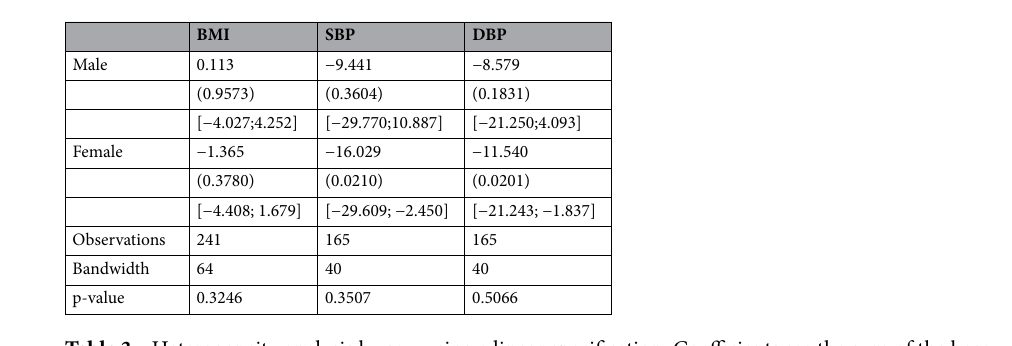
Table 3. Heterogeneity analysis by sex, using a linear specification. Coefficients are the sum of the base treatment effect and the respective group interaction effect. P-values are reported in parentheses, 95% confidence intervals in square brackets.